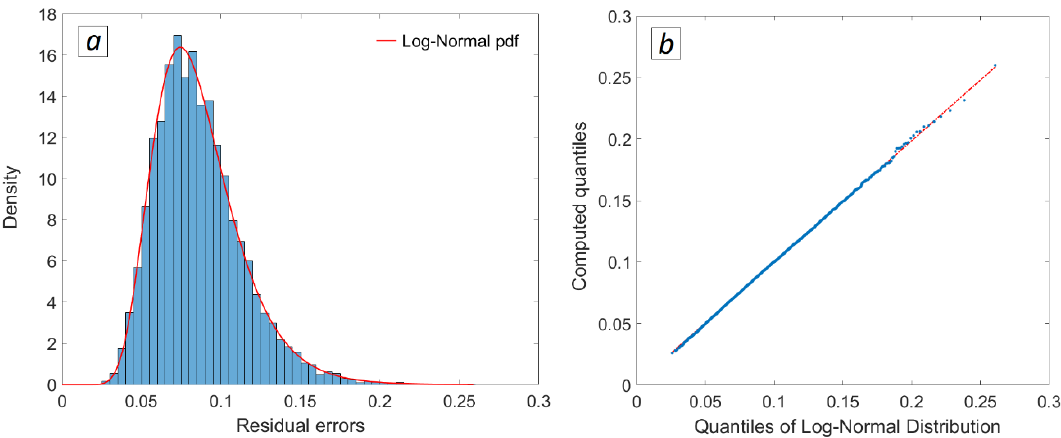
Figure 3. ( a ) Histogram of residual errors and log-normal PDF and ( b ) Q–Q plot of residual